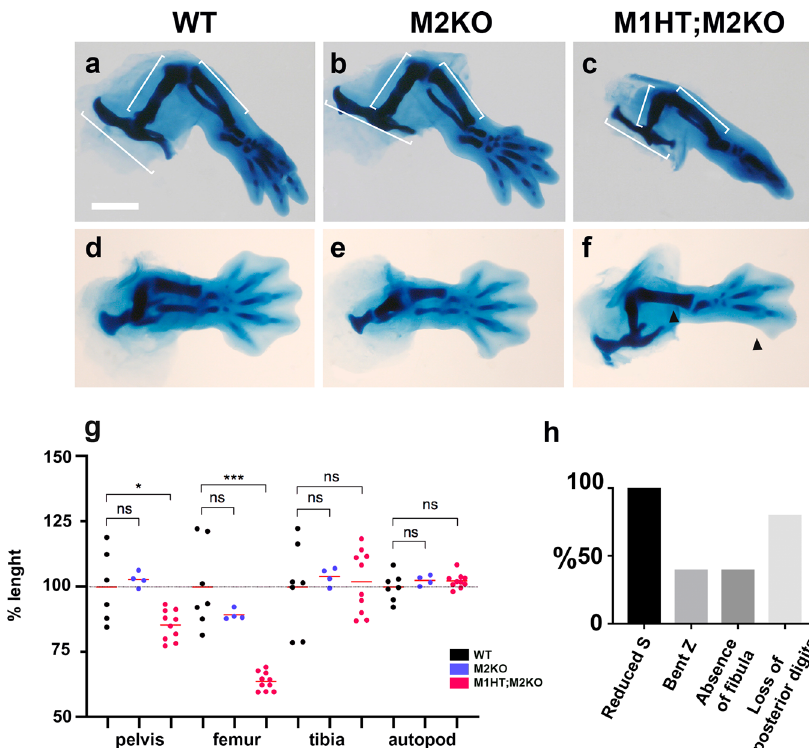
Fig. 2 Skeletal defects in limb buds lacking three Meis1/2 alleles. a – f Victoria blue cartilage staining of HLs at E14.5 in WT embryos, with homozygous deletion of Meis2 (M2KO), and M2KO embryos compound with a Meis1 knockout allele in heterozygosity (M1HT;M2KO). Scale bar = 1000 μ m. g Percentage size change in skeletal elements of M2KO and M1HT;M2KO HLs. Limbs analyzed: WT N = 6; M2KO N = 4 and M1HM2KO N = 10. ns, non- signi fi cant; * p < 0.05, ** p < 0.01, *** p < 0.001. Two-tailed, unpaired Mann – Whitney test. Red bars are mean values. Exact p -values from left to right: 0.7619; 0.0420; 0.4121; 0.0001; 0.6485; 0.9623; 0.3152; 0.3148. h Percentage occurrence of skeletal alterations in M1HT;M2KO HLs. Arrowheads in f indicate the absence of fi bula and posterior digits in M1HT;M2KO specimens. N = 10 embryos. Source data are provided as a Source Data fi le. Source images are available at Mendeley Data 80 [https://data.mendeley.com/datasets/r774bxyf8d/2]. NATURE COMMUNICATIONS| (2021) 12:3086